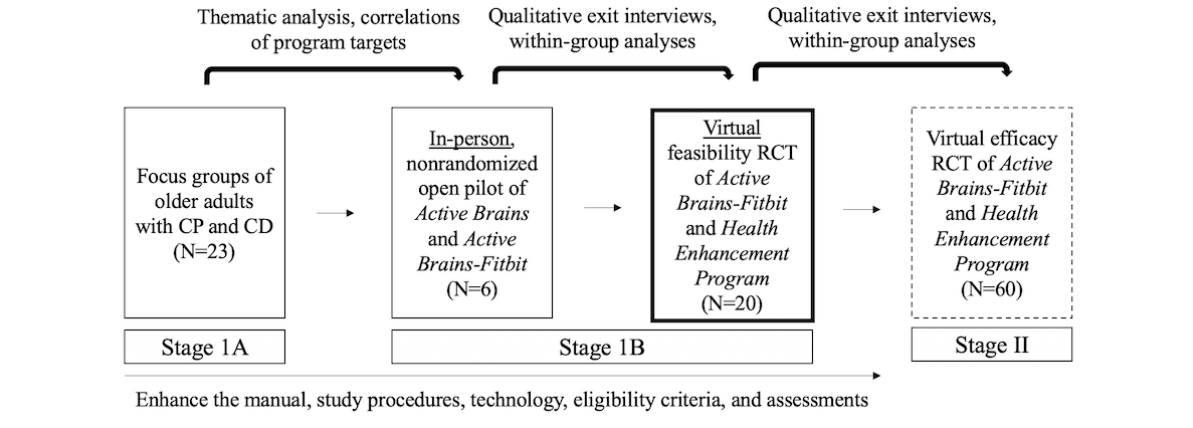
Figure 1. Iterative stages of Active Brains-Fitbit development. The study described in this protocol is outlined in bold. The subsequent efficacy randomized controlled trial is outlined by a dashed line. CD: cognitive decline; CP: chronic pain; RCT: randomized controlled